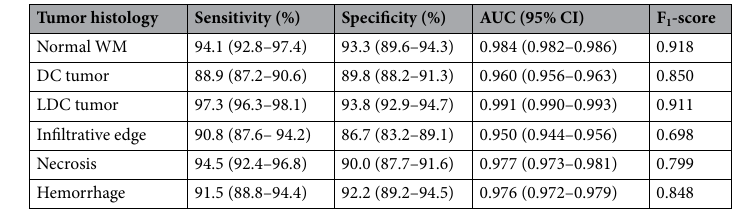
Table 2. Diagnostic performances of DHI in classifying different tumor histologies. The 95% confidence interval (CI) values were calculated using percentile bootstrap method with 10,000 independent experiments. CI confidence interval, Normal WM normal white matter, DC tumor densely cellular tumor, LDC tumor less densely cellular tumor.